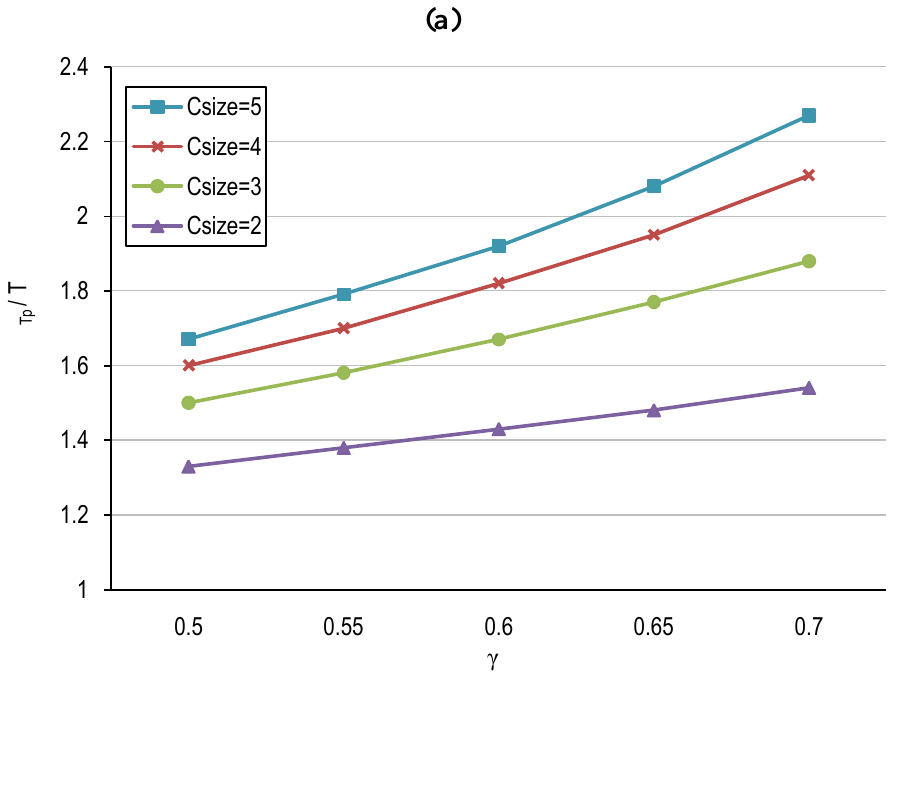
Figure 10. (a) Sensor node duty-cycle period T